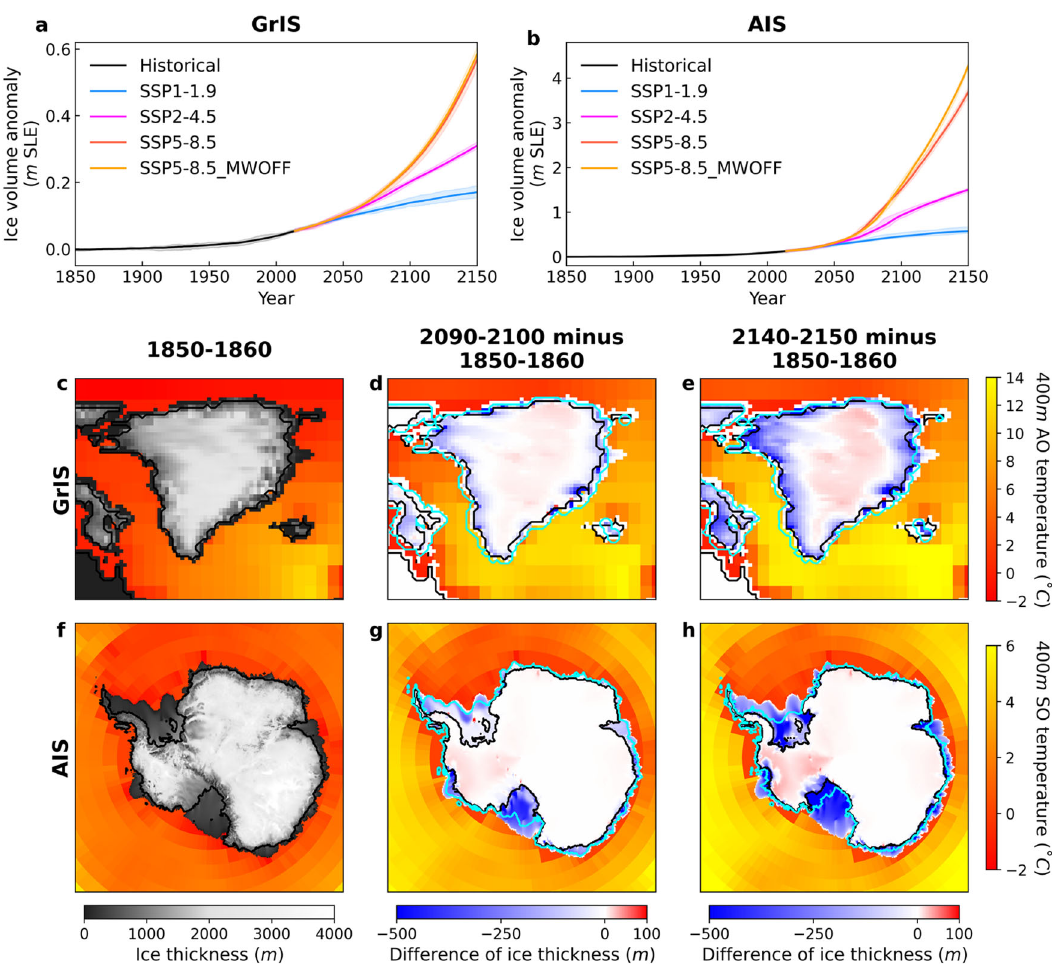
Fig. 3 | Projected changes in mass balance, ice thickness and subsurface ocean temperature. a , b Time series of the annual mean ( a ) Greenland ice-sheet (GrIS) and ( b ) Antarctic ice-sheet (AIS) net mass balance in sea-level-equivalent (SLE) (includingcontributionsfromiceshelves),respectively; c GrIS1850 – 1860CEmean icethickness(grayscalecolormap)and400mArcticOcean(AO)temperature(red- yellow colormap); d 2090 – 2100 CE change in SSP5-8.5 scenario of GrIS ice